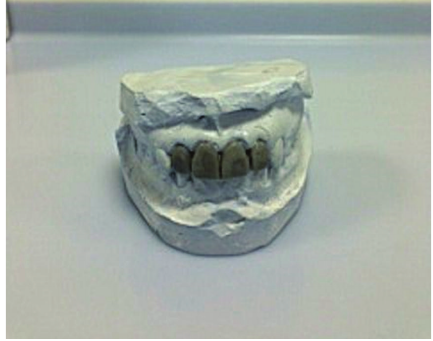
Figure 3: Diagnostic wax-up for the missing teeth.